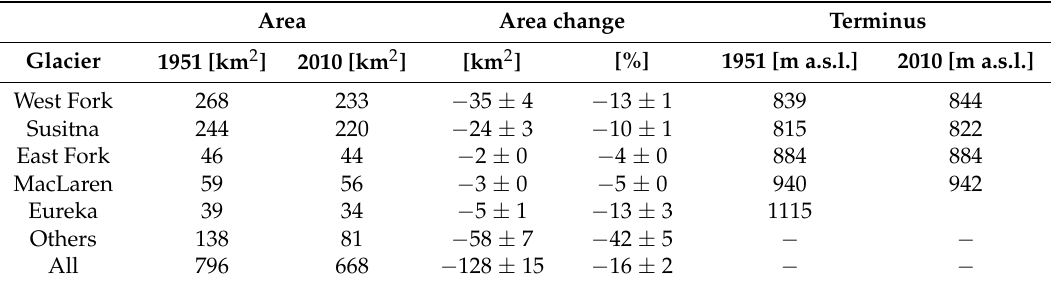
Table 2. Glacier area and terminus elevation in 1951 and 2010 and the area change between 1951–2010 for the five largest glaciers and all glaciers in the Susitna basin. Glaciers termed as “Others” include all unnamed, smaller glaciers (shaded in light grey in Figure 1). Terminus elevations were extracted from the corresponding DEMs. Area Area change Terminus Glacier 1951 [km 2 ] 2010 [km 2 ] [km 2 ] [%] 1951 [m